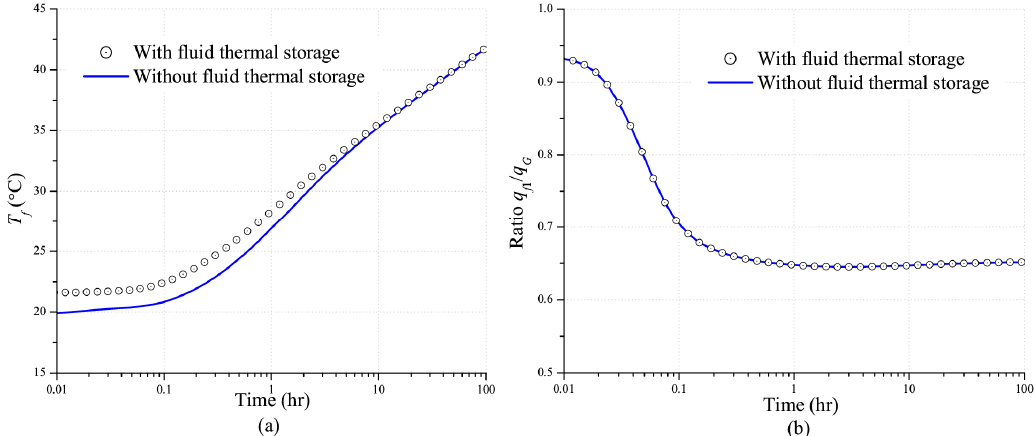
Figure 3. Thermal response plots calculated with the proposed model with different ω f : ( a ) average temperature of the fluid; and ( b ) ratio of the heat rate of the descending leg.